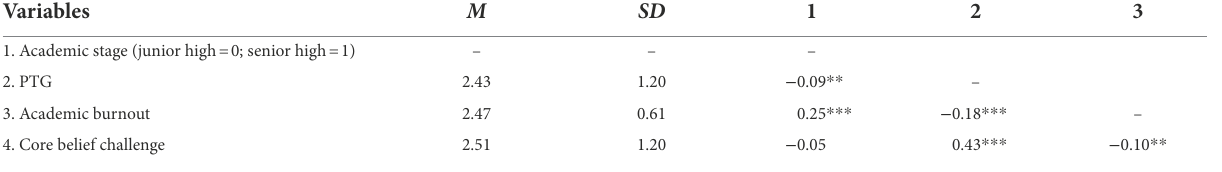
TABLE 3 Descriptive statistics and inter-correlations between variables.